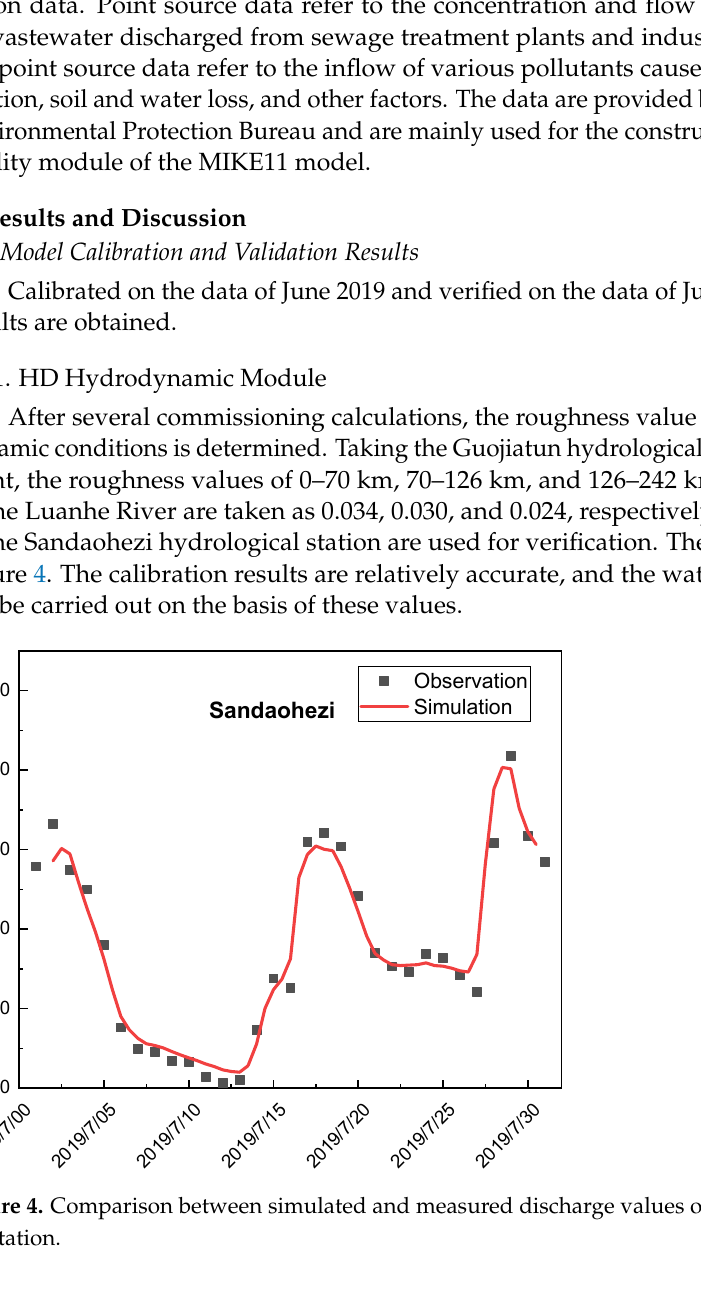
Table 6. Error statistics of NH 3 -N and COD simulation results of the MIKE11 water quality model Sections